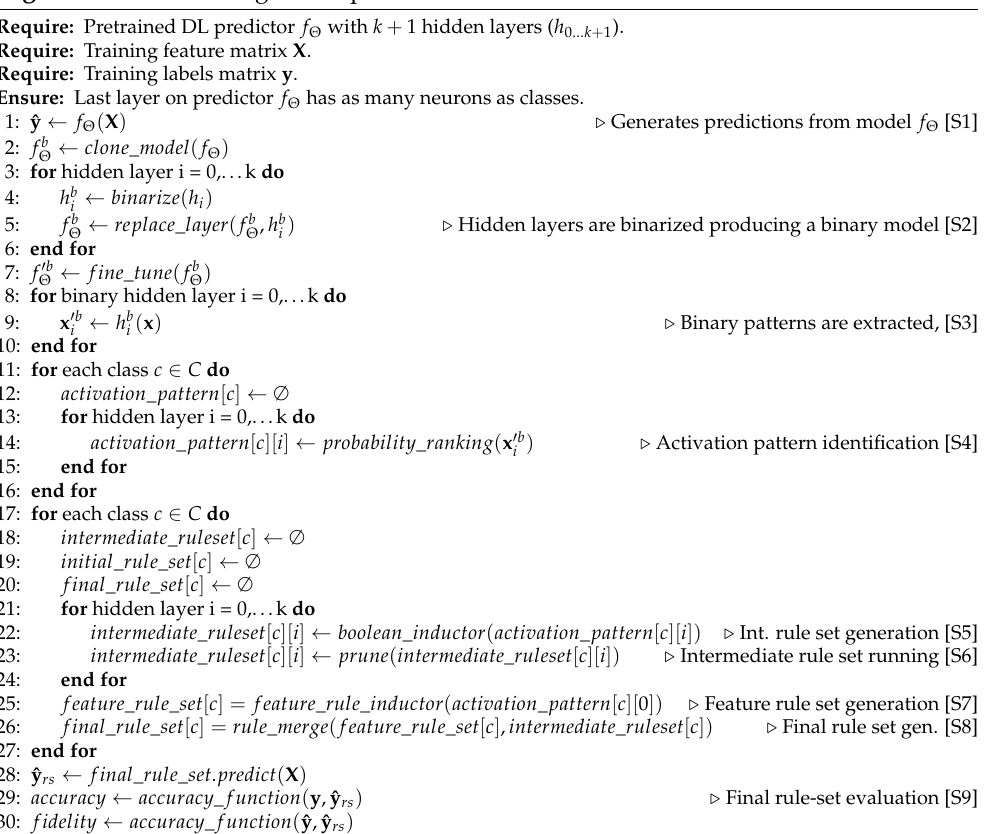
Algorithm 1 DEXiRE algorithm